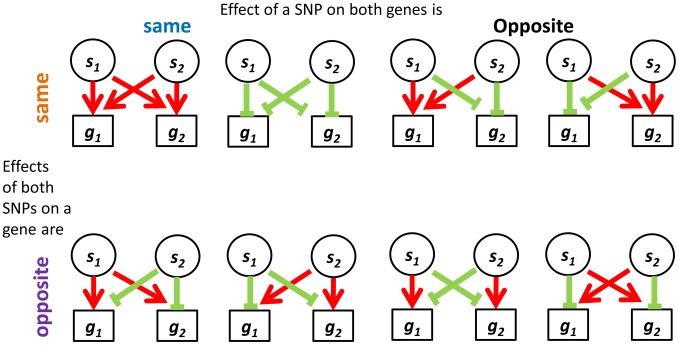
Four categories describing the eight configurations of directions of effect observed in real data between eSNP sources and gene targets.Both SNPs can have the same or opposite effect on a gene and both genes may experience the same or opposite effect of a SNP.